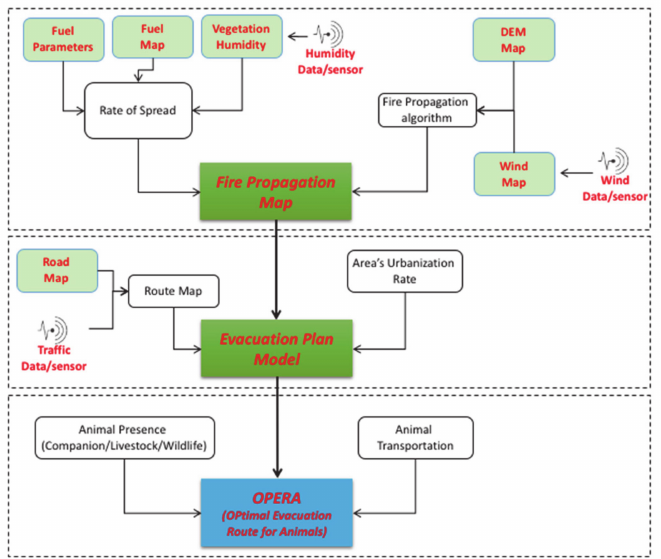
Figure 2. Architecture of the proposed conceptual